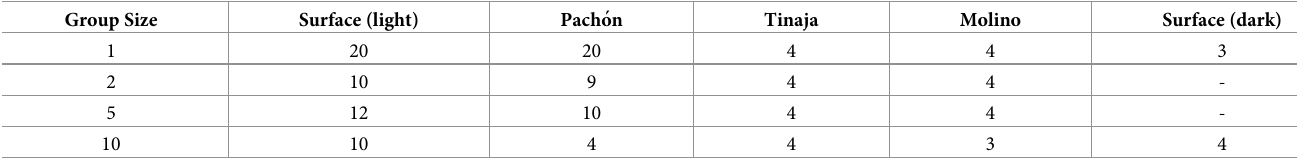
Table 1. Number of trials collected for each population and group size. Group